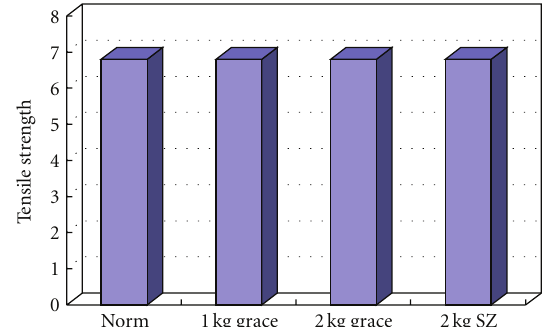
Figure 13: Tensile strength comparison.